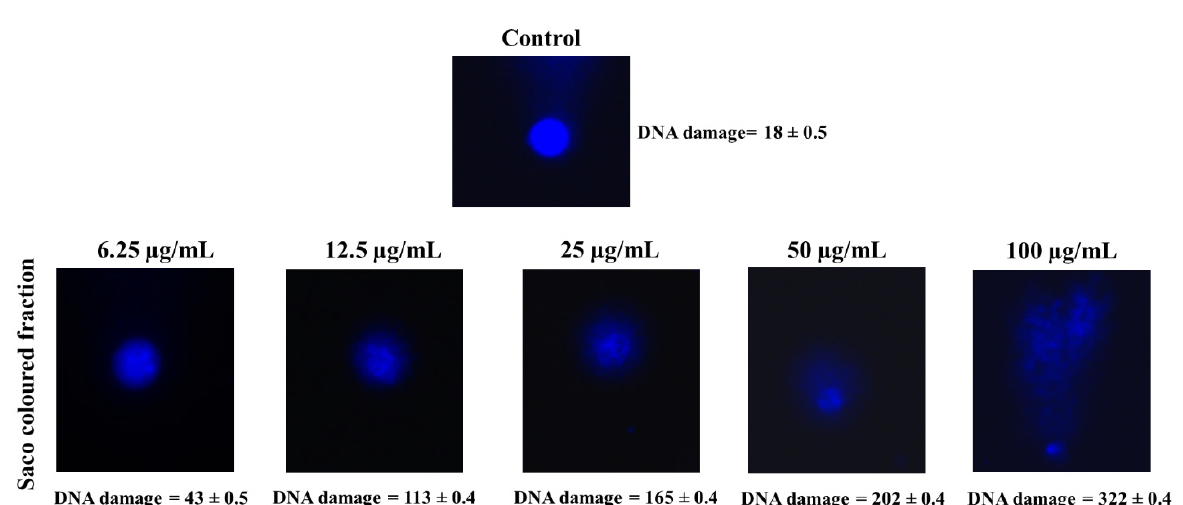
Figure 4. Nuclear morphological study by 4 ′ ,6-diamidine-2 ′ -phenylindole dihydrochloride staining of HepG2 cells (control vs. treatment after 72 h of incubation). ( A ) corresponds to the control, ( B , E , H ) correspond to Saco total extract, while ( C , F , I ) to the coloured fraction and ( D , G , J ) to the non-coloured one, at concentrations of 25, 50 and 100 µg/mL, respectively. Three independent ex- periments were performed, and a representative field was selected.